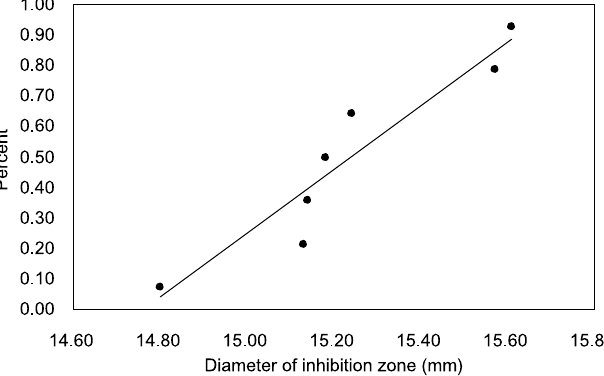
dose (diameter 1